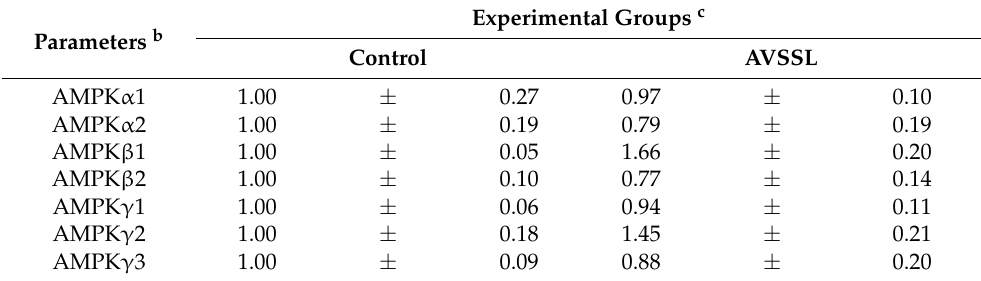
Figure 6. Effect of the phytogenic water additive SG on the expression of protein metabolism-related proteins and genes in breast muscle tissue. Protein levels of phosphorylated mTOR, mTOR, and VCL ( a , b ) were measured by Western blot and mRNA abundances of mTOR and RPS6KB1 ( c , d ) were determined by qPCR using the 2 − ∆∆ Ct method [21]. Data are presented as the mean ± SEM ( n = 8 birds/ group). * Denotes significant difference compared to the control group at p < 0.05. mTOR, mechanistic target of rapamycin; RPS6KB1, ribosomal protein S6 kinase beta-1. Table 3. Effect of the phytogenic water additive AVSSL on muscle AMPK pathway a .